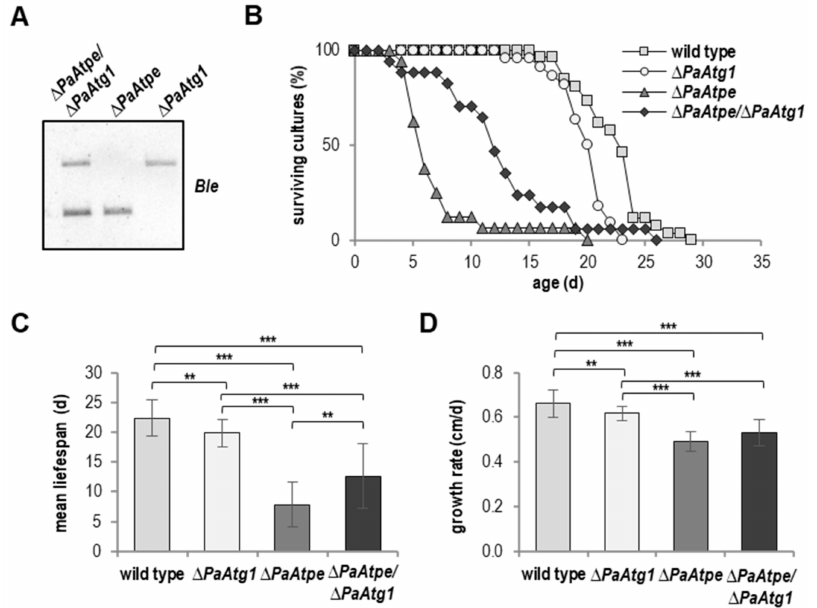
Figure 4. Autophagic processes contributes to lifespan decrease of ∆ PaAtpe . ( A ) Southern blot analy- sis verifies the newly generated double deletion mutant ∆ PaAtpe/ ∆ PaAtg1 by the phleomycin ( Ble ) resistance genes ( B ) Survival curve of P. anserina wild type ( n = 26), ∆ PaAtg1 ( n = 22; p = 2.6 × 10 − 3 ), ∆ PaAtpe ( n = 16; p = 7.5 × 10 − 11 ) and ∆ PaAtpe/ ∆ PaAtg1 ( n = 17; p = 2.6 × 10 − 8 ) grown on standard M2 medium. ( C ) Mean lifespan and ( D ) mean growth rates of cultures from (B). Error bars correspond to standard deviation. The p -values of the survival curves were determined by SPSS with three different tests and for mean lifespan and growth rate by two-tailed Student’s t test. ** p < 0.01; *** p < 0.001.